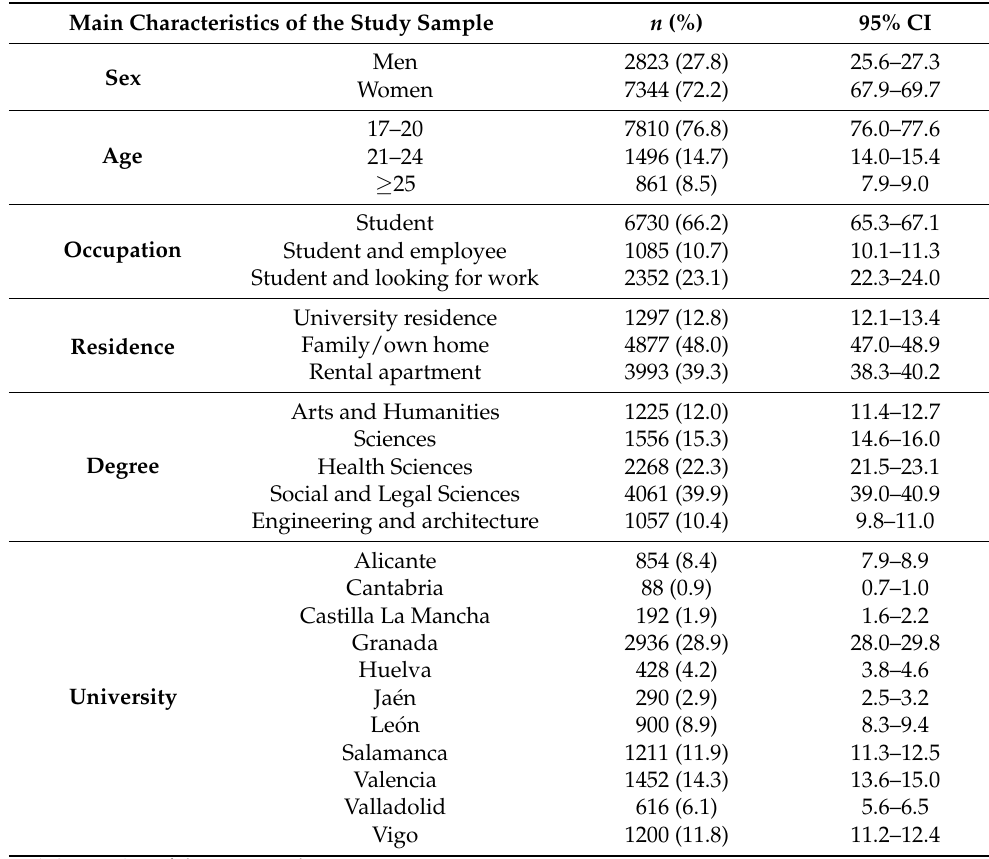
Table 1. Main characteristics of the study sample ( n =